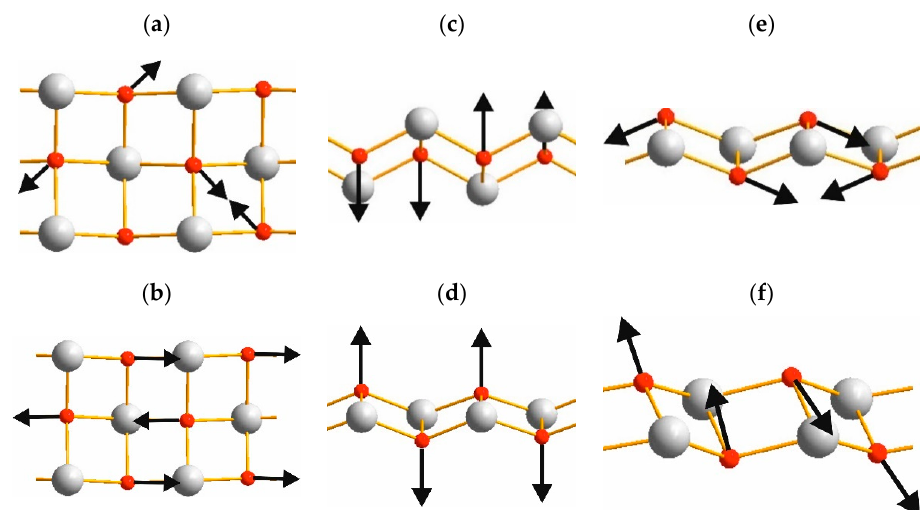
Figure 8. Representative atomic vibrations of [Y 2 O 2 2+ ] chains in Y 2 O 2 SO 4 : ( a ) B g 533.1 cm − 1 , ( b ) A g 505.3 cm − 1 , ( c ) B g 383.2 cm − 1 , ( d ) A g 352.5 cm − 1 , ( e ) A u 546.7 cm − 1 , (f) B u 499.1 cm –1 .